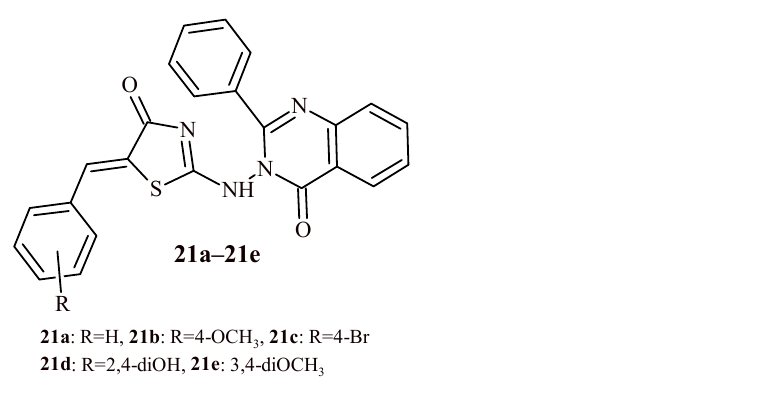
Figure 11. The structures of thiazolidin-4-one derivatives with EGFR inhibitory activity. Compounds 21a – 21d showed significant cytotoxic effect against both MCF-7 and A549 cell lines (Table 1). Table 1. Anticancer activity of the synthesized compounds ( 21a – 21e ) against MCF-7 and A549 cell lines.